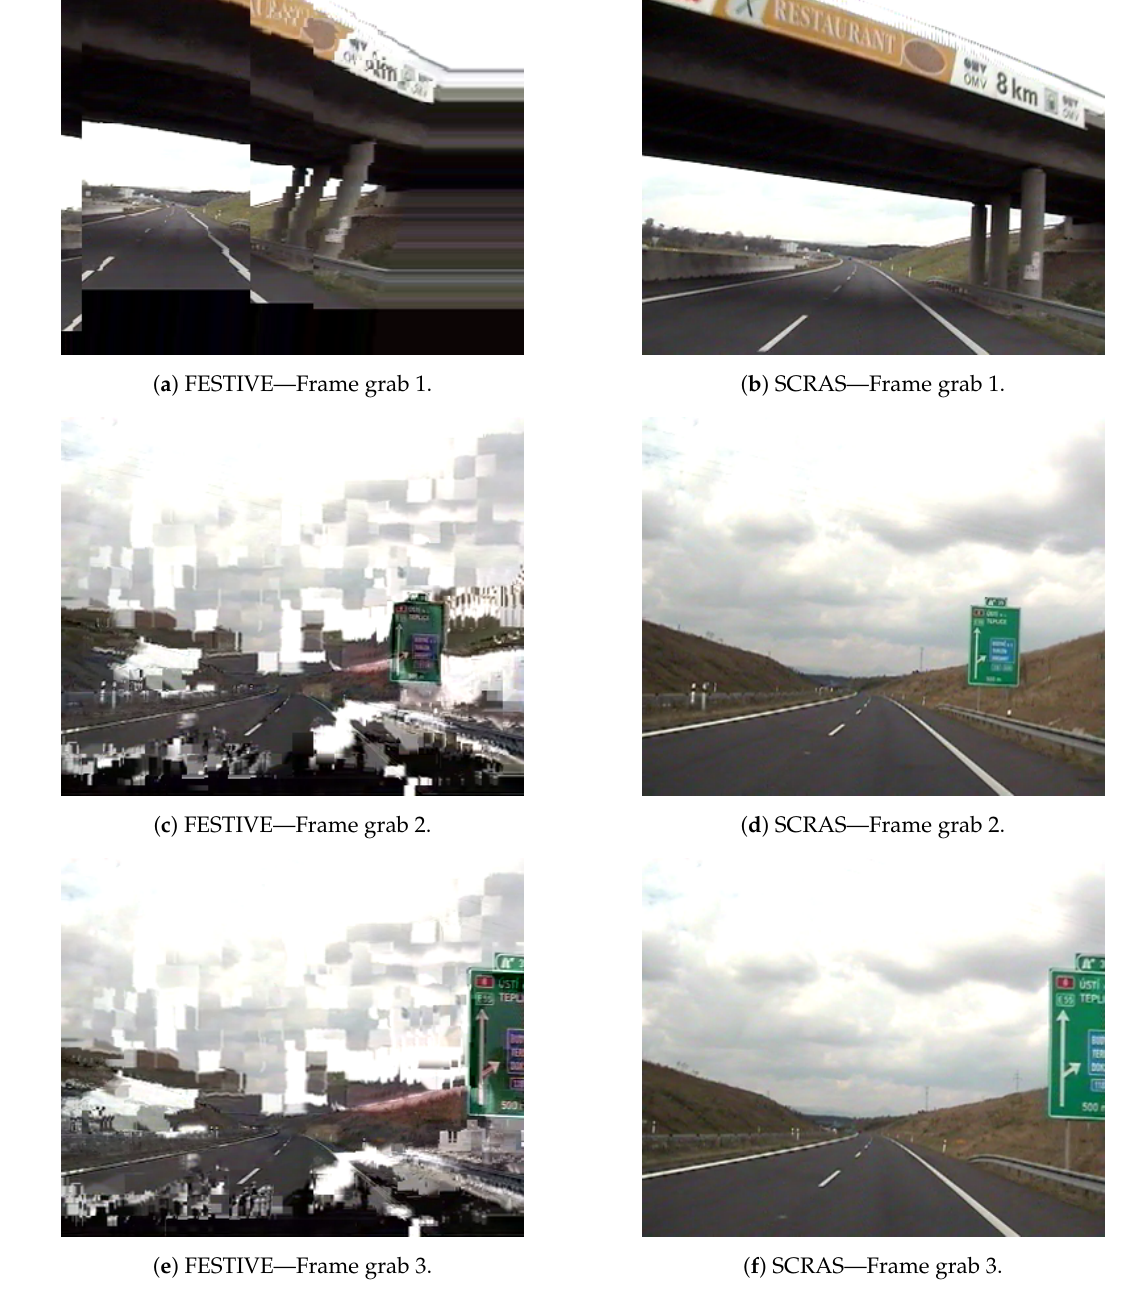
Figure 11. Frame-grabs of streaming video showing SCRAS outperform FESTIVE before FESTIVE reacts to the poor